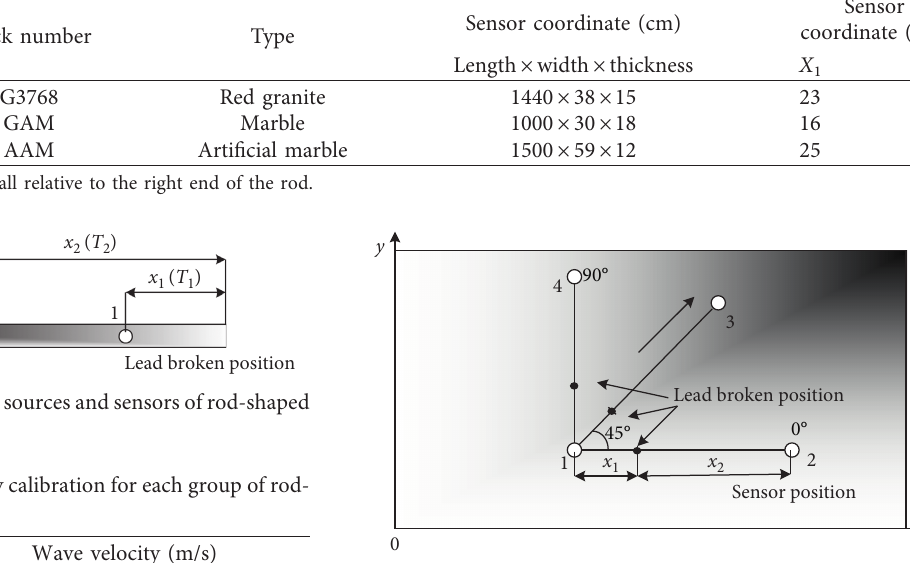
Figure 2: The coordinate of AE sources and sensors of plate-shaped